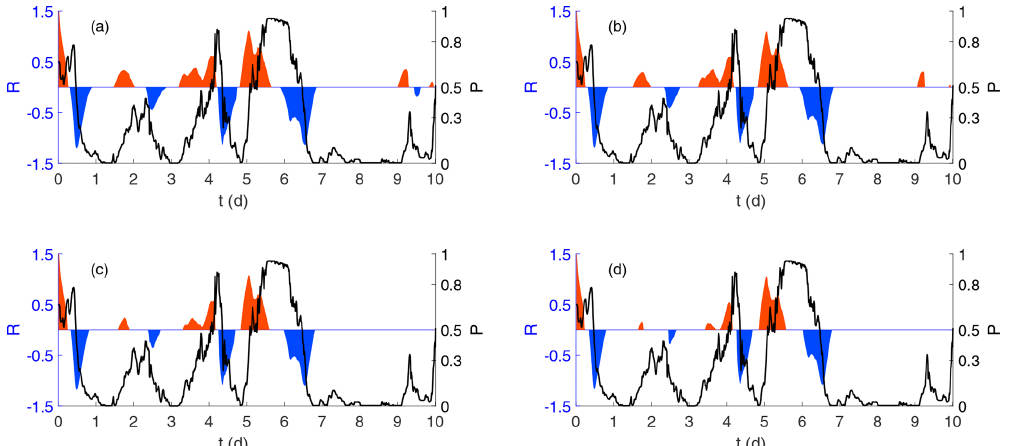
( a,b ) using the (a) 10%, i